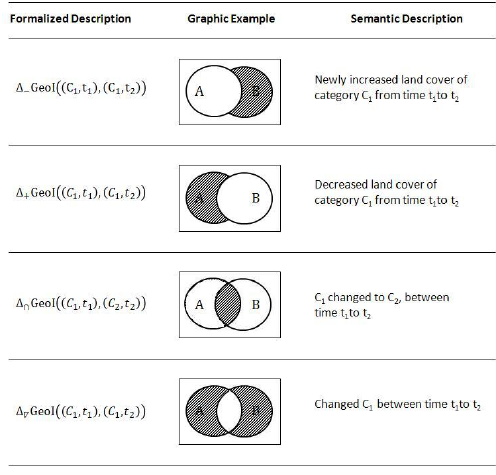
Table 2 The semantic description of operation relation for